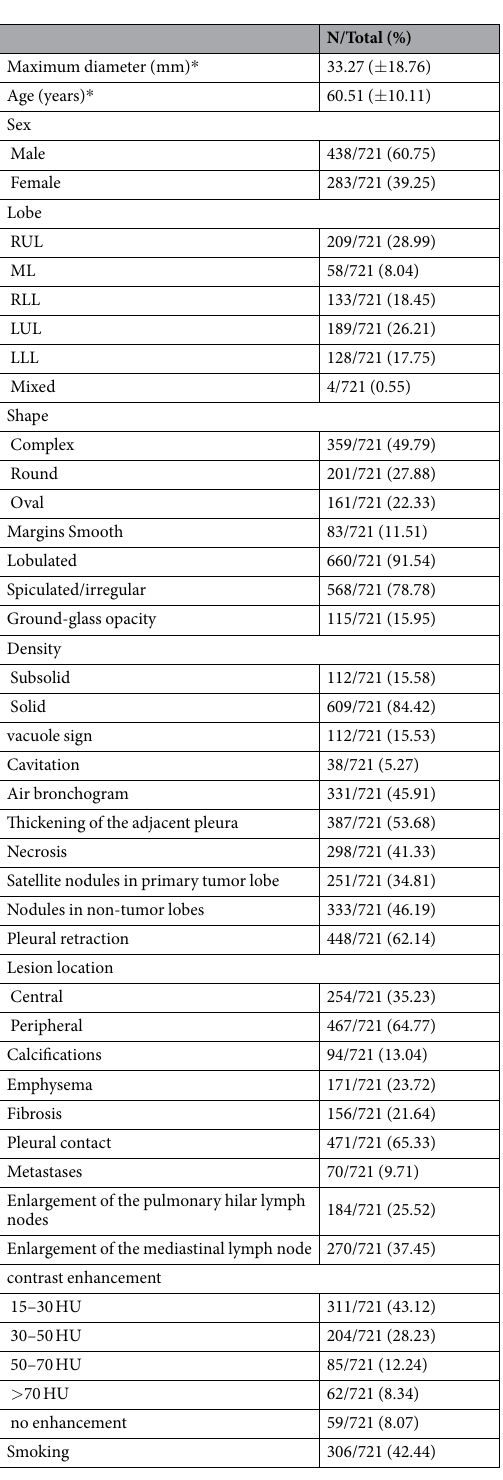
Table 1. CT and clinical characteristics of the study population. * Mean ( ±